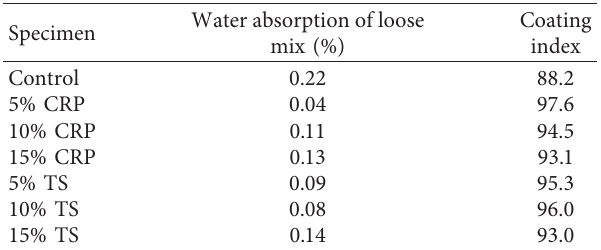
Table 13: Coatability test results of the control and waste-modified asphalt mixtures.